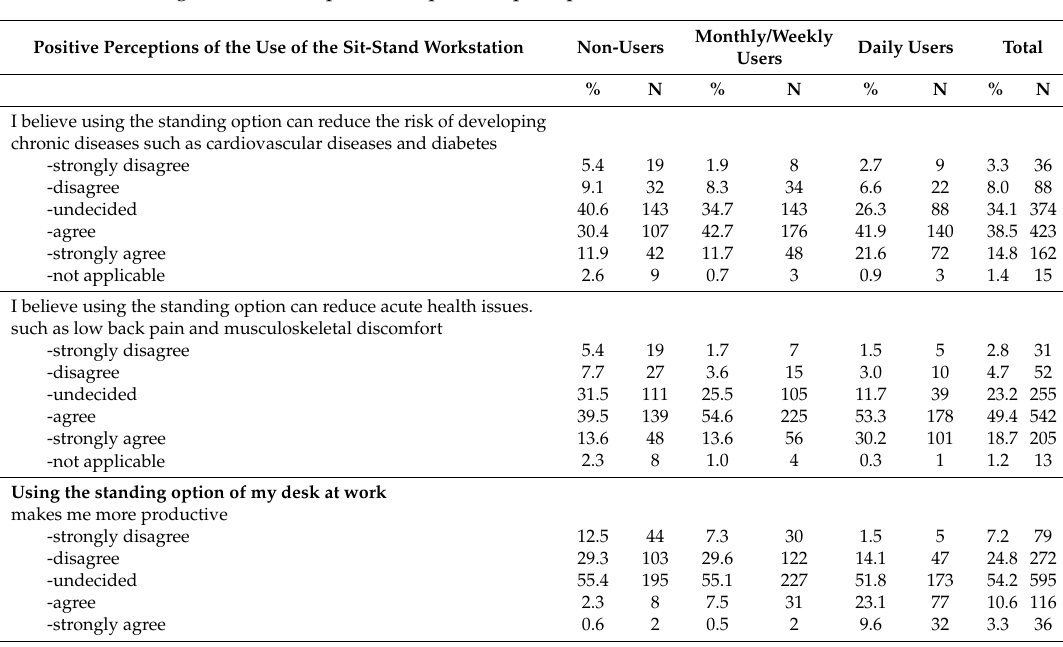
Table A5. Agreement with perceived positive perceptions of the use of the sit-stand